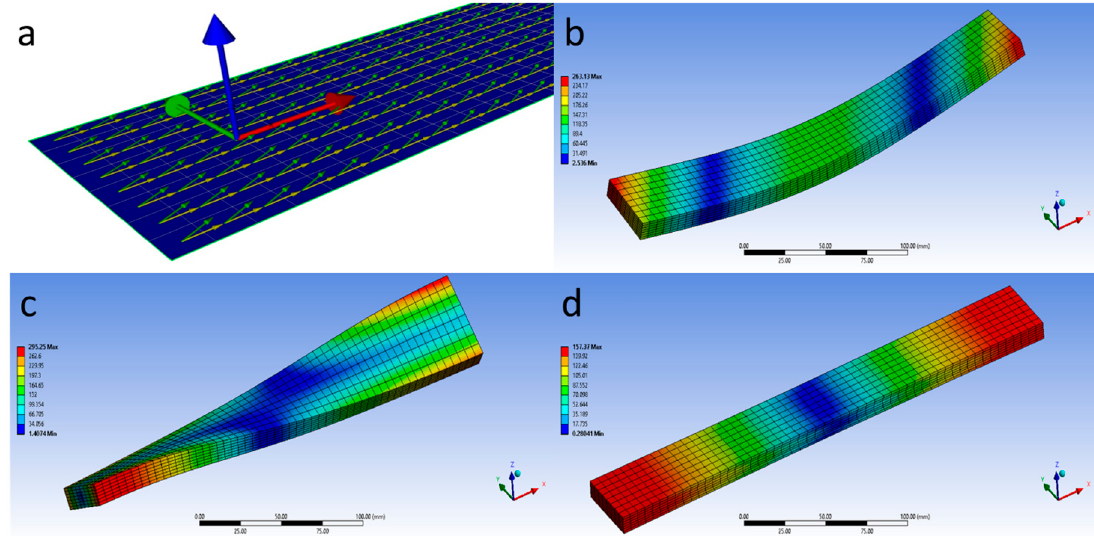
Figure 9. Composite finite element model using Ansys software for a specimen 7A with first ply orientation of 22.5°: ( a ) first layer with specimen coordinate system and designation of the main direction (yellow arrow) and first ply orientation (green arrow); ( b ) relative deformation of the first flexural vibration mode in specimen coordinate system; ( c ) relative deformation of the first torsional vibration mode in specimen coordinate system; ( d ) relative deformation of the first longitudinal vibration mode in specimen coordinate system.